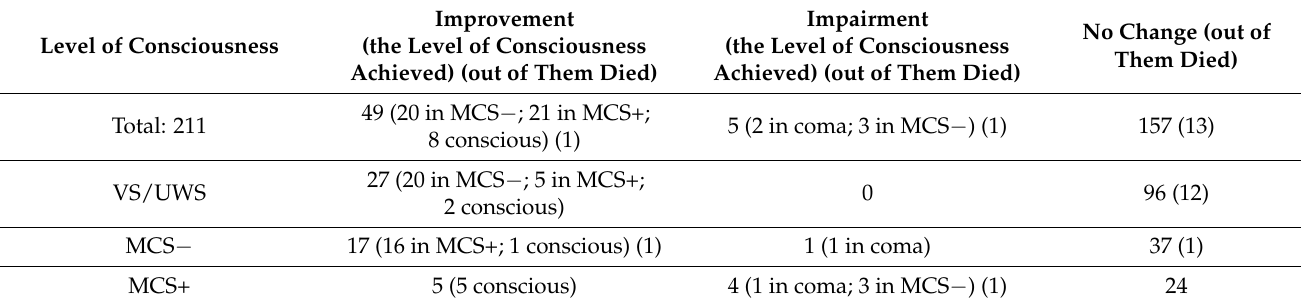
Table 4. Changes in the level of consciousness at the 3 month